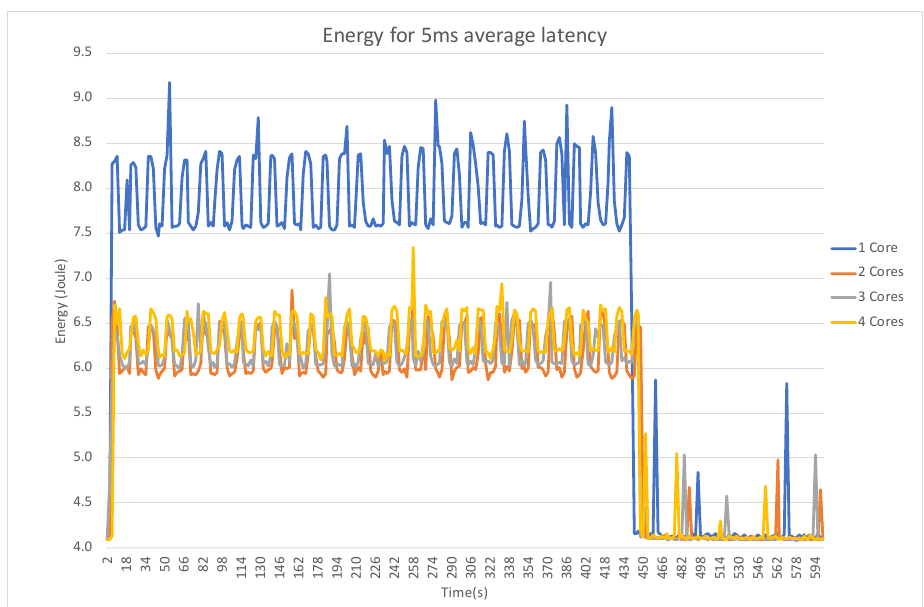
Figure 14. Energy consumed during the last second that proceeds the measurement for different number of cores during network average latency test with 5 ms